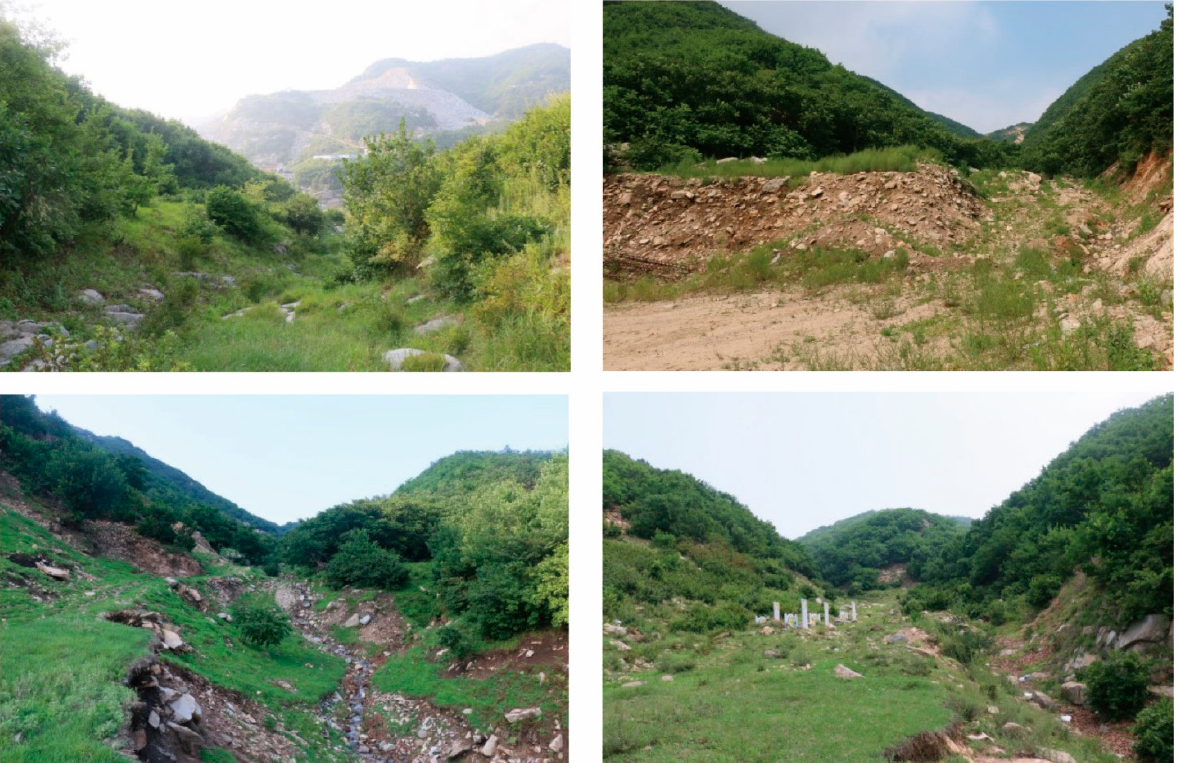
Figure 2. Landforms in the Laomao Mountain debris flow